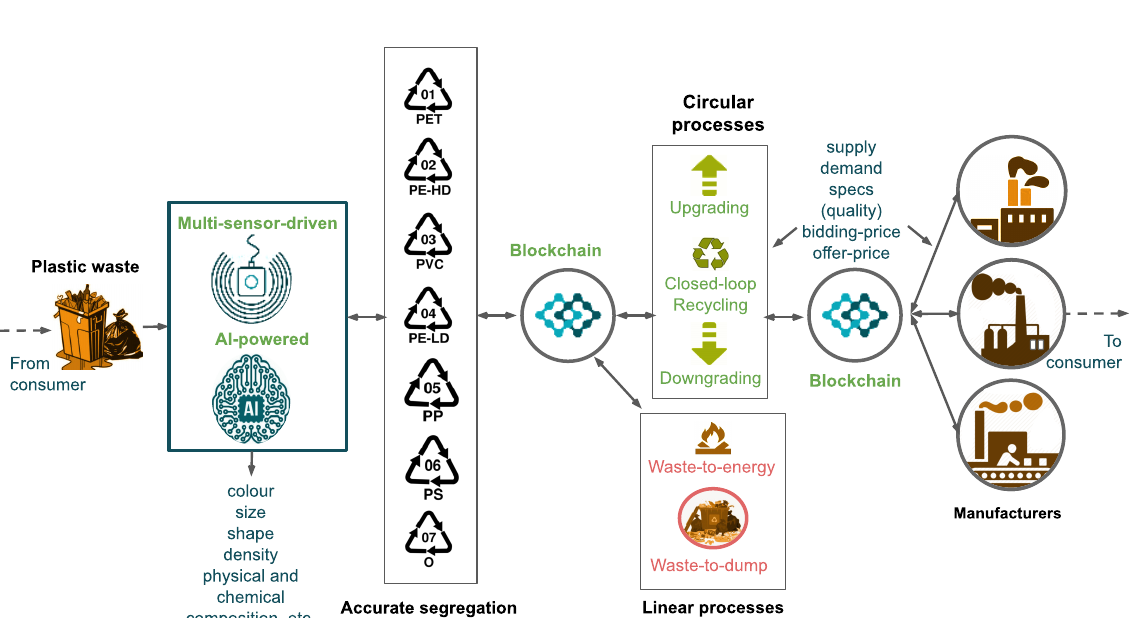
Fig. 2. Multi-sensor-driven AI and blockchain tools for efficient segregation and recycling of plastic